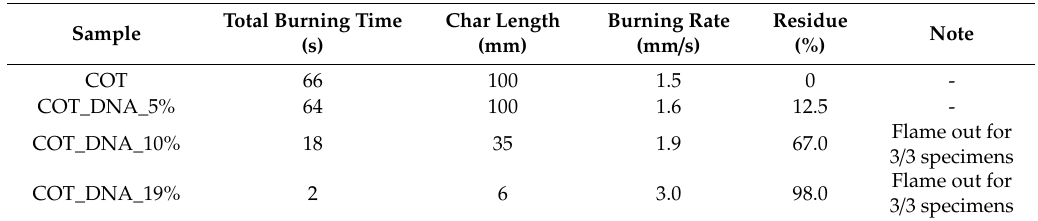
Table 9. Results from horizontal flame spread tests performed on untreated and DNA-treated cotton fabrics.